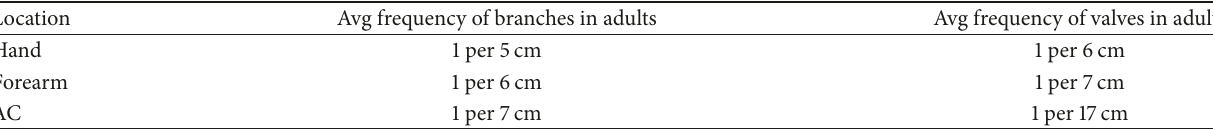
Table 2: Frequencies of branches and valves in adults ∗ .